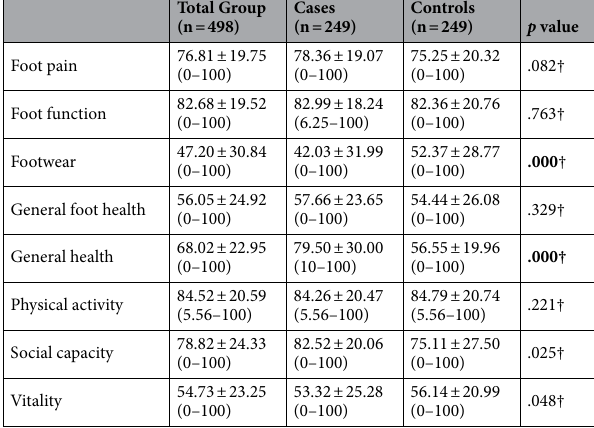
Table 2. Comparison of FHSQ scores of the total sample, patients with foot problems and controls. † Median ± IR (range) and Mann–Whitney U test were utilised. In all the analyses, p < .05 (with a 95% confidence interval) was considered statistically